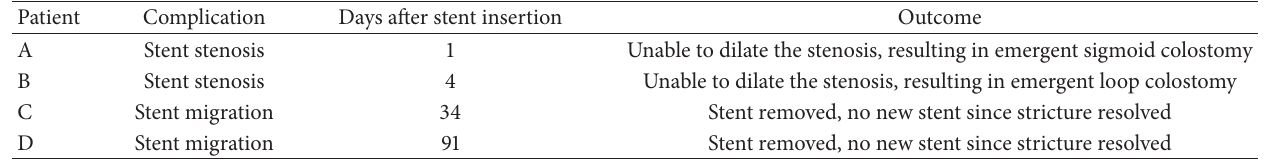
Table 4: Patients with complications.